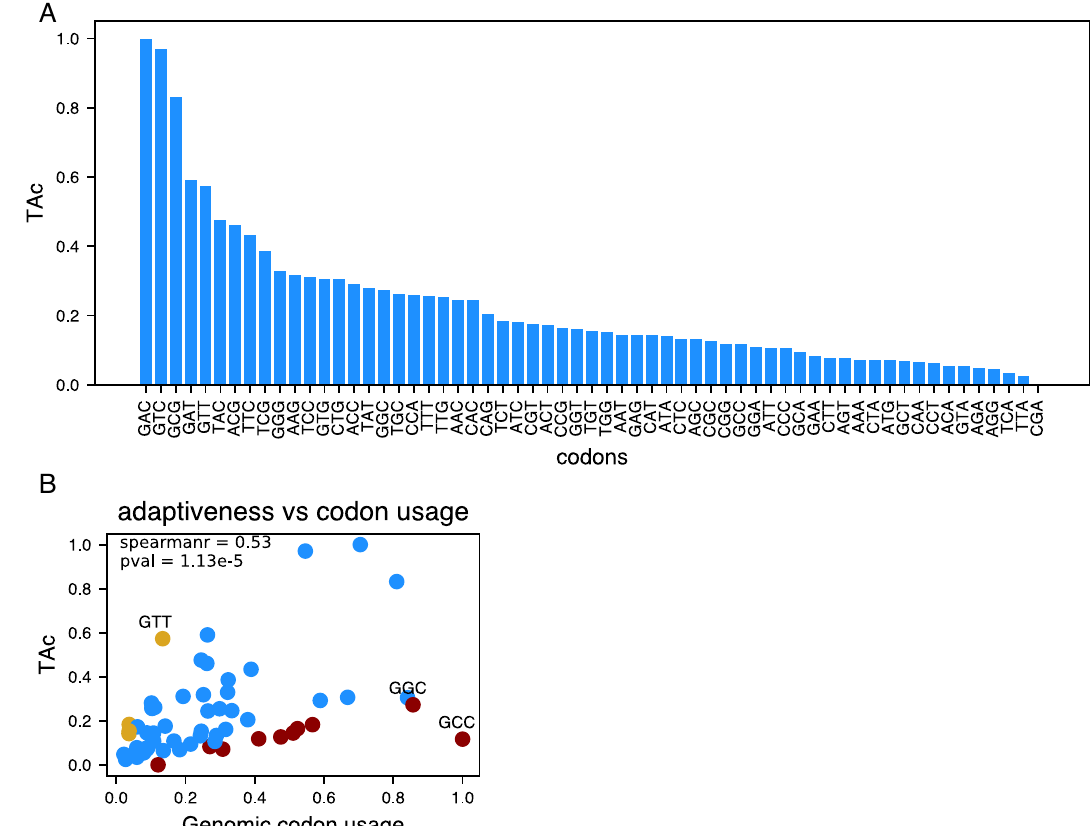
Figure 2. tRNA adaptability of codons in Mtb. ( A ) TAc values calculated using the tRNA abundance rather than gene counts. ( B ) A scatterplot showing the correlation between the genomic codon usage and TAc values. Spearman correlation coefficient and the p-value are given in the